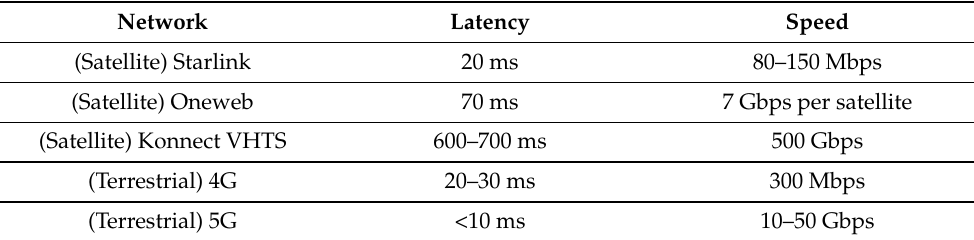
Table 1. Comparison of satellite and terrestrial networks.